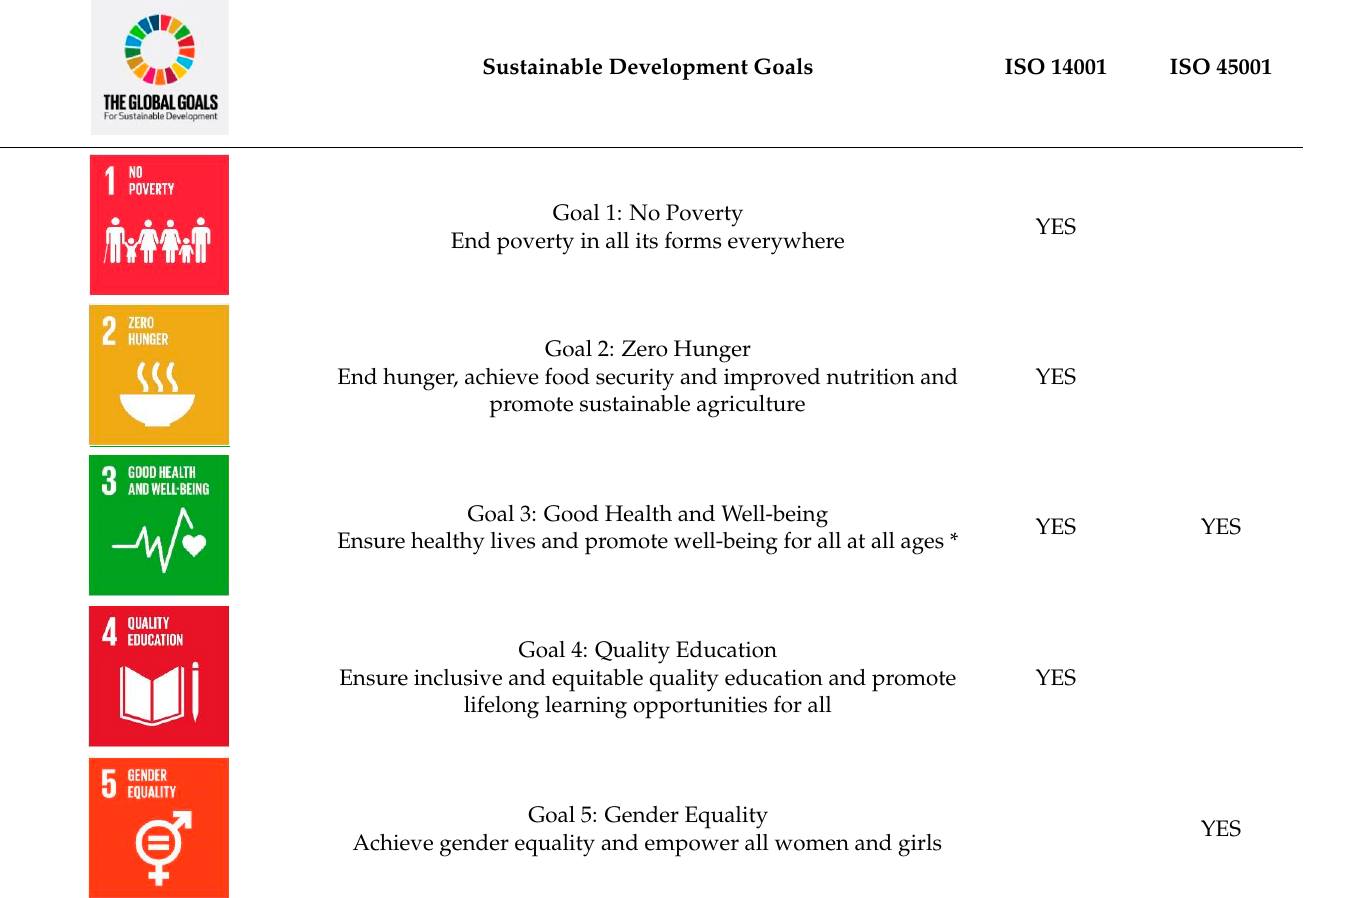
Table 1. ISO 14001 and 45001 contribute to the following Sustainable Development Goals (Adapted with permission from [20] by the authors).